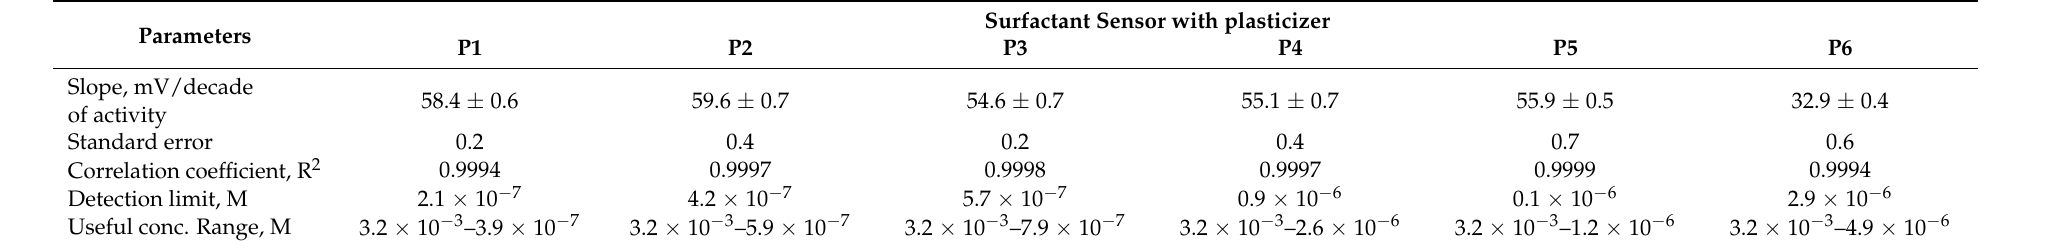
Table 5. Statistics of the response characteristics of the P1–P6 surfactant sensors to DMIC, given together with ± 95% confidence